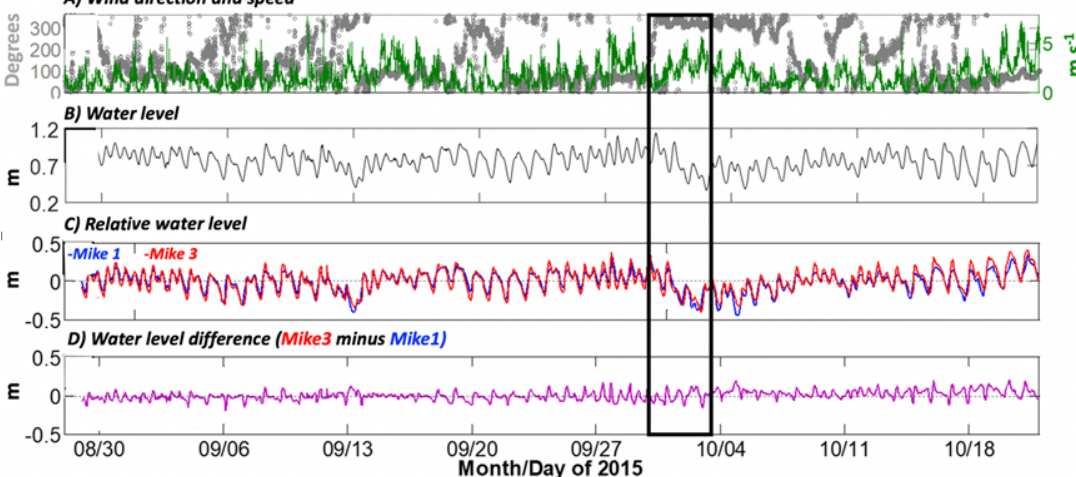
Figure 5. Wind speed and relative water elevation data during the instrument deployment in Mike Island (Wax Lake Delta, LA, USA) in September–October 2015; ( A ) wind direction and speed, ( B ) water lever, ( C ) relative water lever, ( D ) water level difference (Mike3 minus Mike1); note the drop in the water level in early October 2015 (rectangle inset). See methods section for instruments’ description. Wind speed and direction data were downloaded from NOAA’s National Data Buoy Center station located at Amerada Pass on Atchafalaya Delta (see methods).